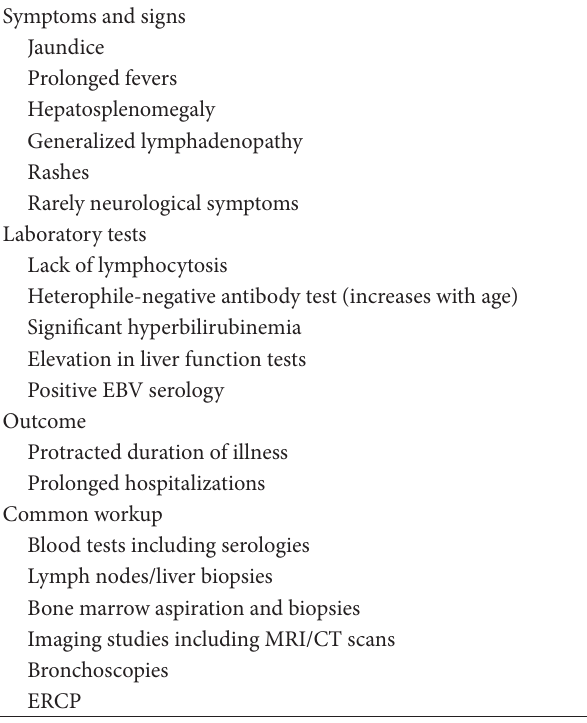
Table 2: Common characteristics of infectious mononucleosis in elderly patients in comparison to younger